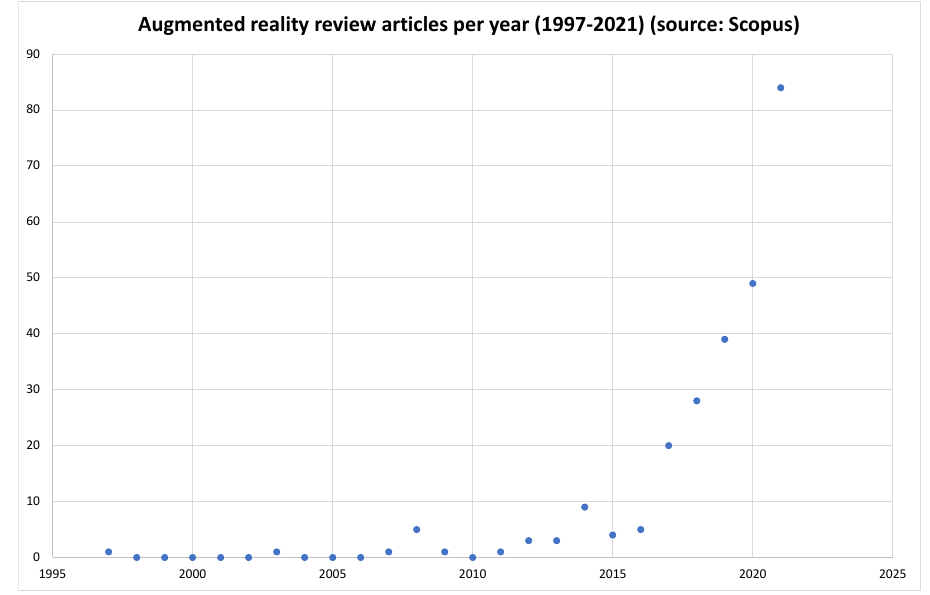
Figure 2. Scopus review articles referring to augmented reality per year